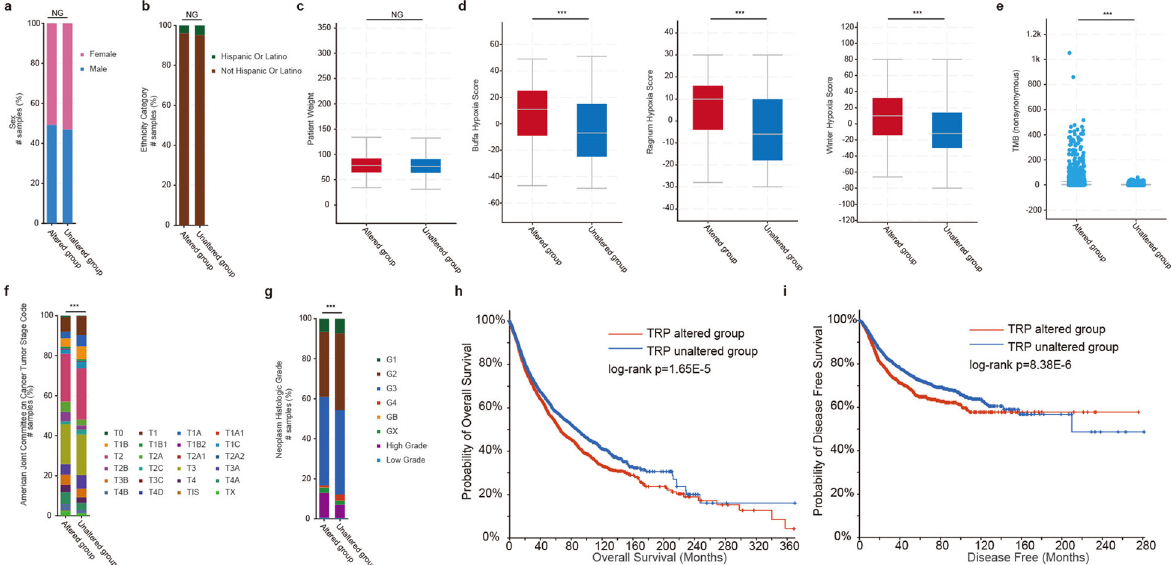
Fig. 4 Clinical relevance of TRPs alterations across cancer types. a Proportions of patients with different sex in TRP altered or unaltered groups. b Proportions of patients with different ethnicity category in TRP altered or unaltered groups. c Patient weights in TRP altered or unaltered groups. d Hypoxia scores of patients in TRP altered or unaltered groups. e Box plots showing the TMBs of patients in TRP altered or unaltered groups. f Stages of patients in TRP altered or unaltered groups. g Grades of patients in TRP altered or unaltered groups. h Kaplan – Meier survival plot of patients grouped by with or without TRP genetic alterations. h for overall survival and i for disease-free survival. Centre line of boxplot is the median, and bounds of box are the upper and lower quartile. ***adjusted p < 0.01, **adjusted p <